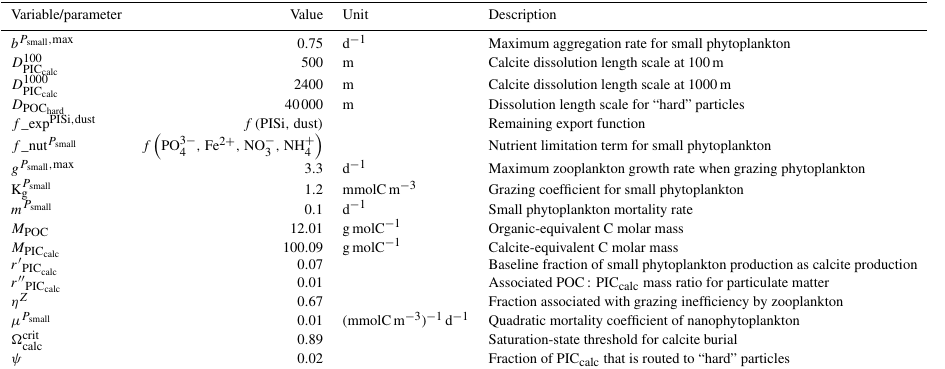
Table C15. MARBL parameters. Variable/parameter Value